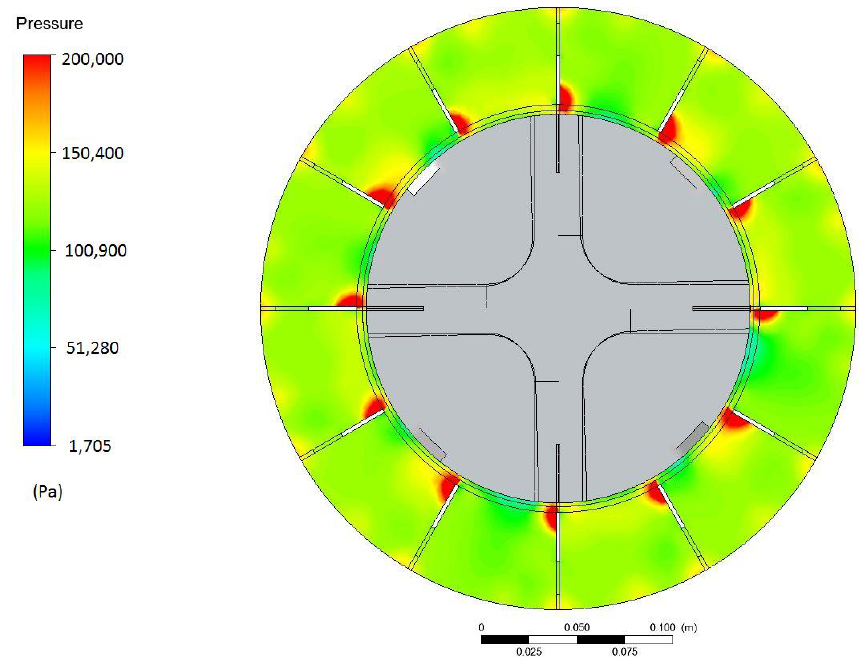
Figure 6. Pressure contour at the outlet from the rotor of the device in the modified variant.